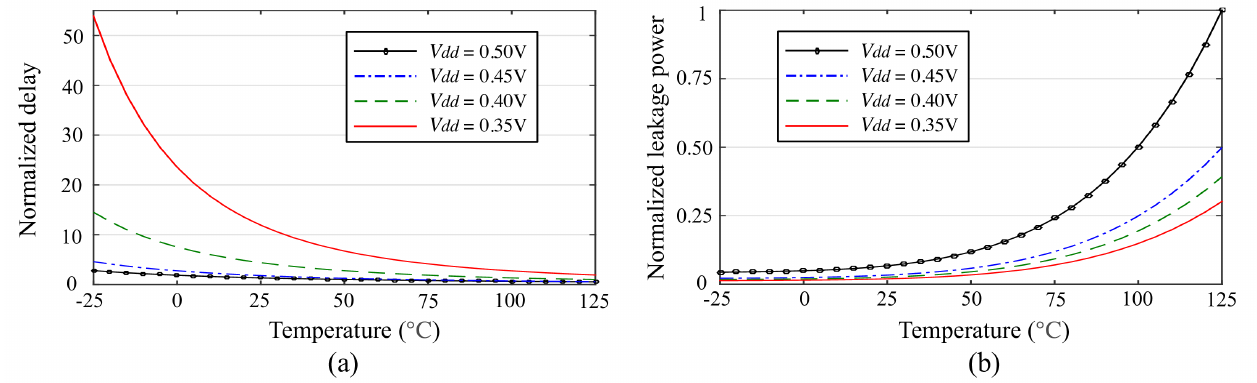
Figure 4. Simulation results of the FO4 inverter chain based on CMOS 40n LP process library: ( a ) normalized delay and ( b ) normalized leakage power consumption under a wide range of temperature values. The normalizations were carried out based on V dd = 0.50 V at 125 ◦